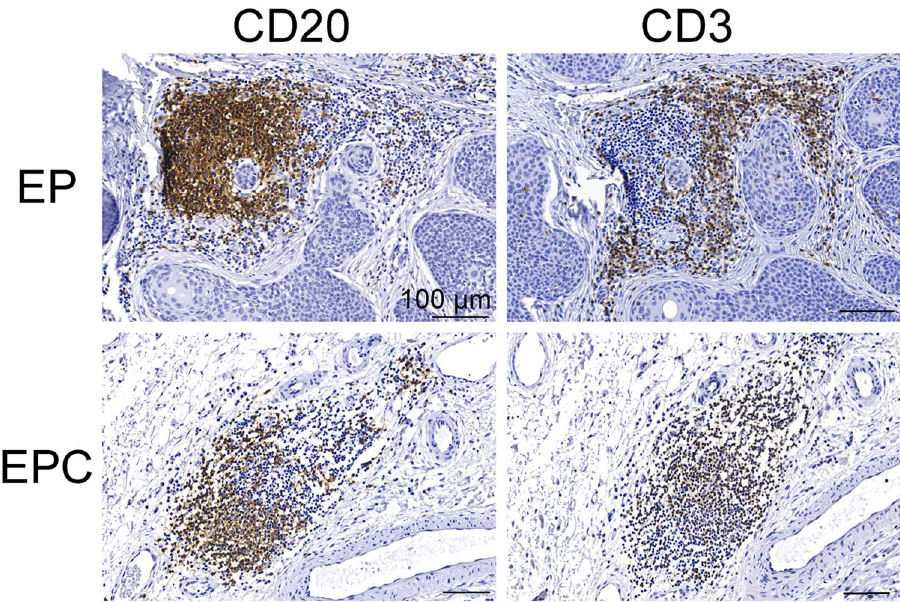
Figure 2. TLSs in EPCs and EPs. Dense CD20+ B cell follicle abuts a CD3+ T cell zone. Scale bar =